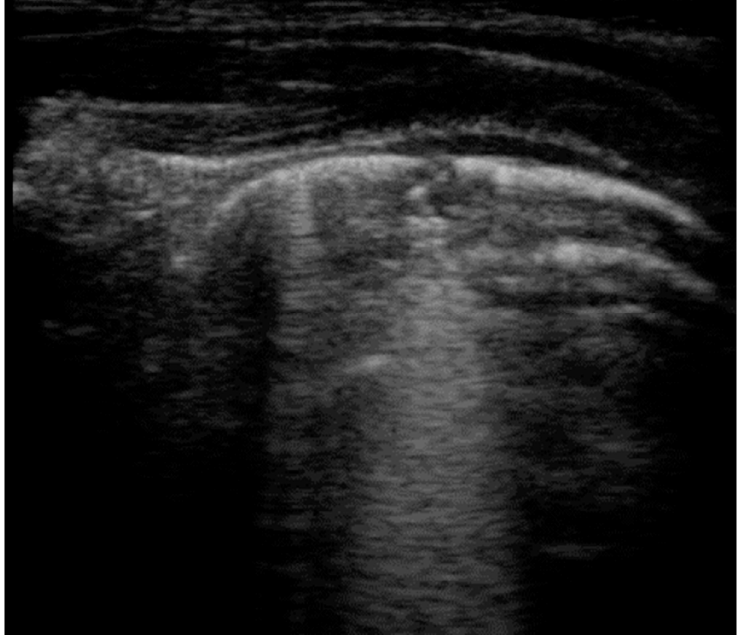
Figure 7. Bronchiolitis: small subpleural consolidation in a newborn, expression of a disease moderate in severity.